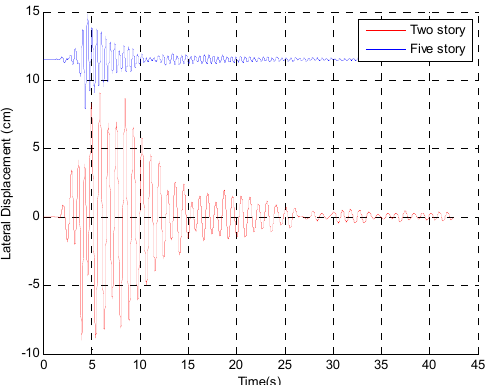
Figure 10. The lateral displacement time histories of two buildings separated by the seismic gap equal to 11.47 cm.